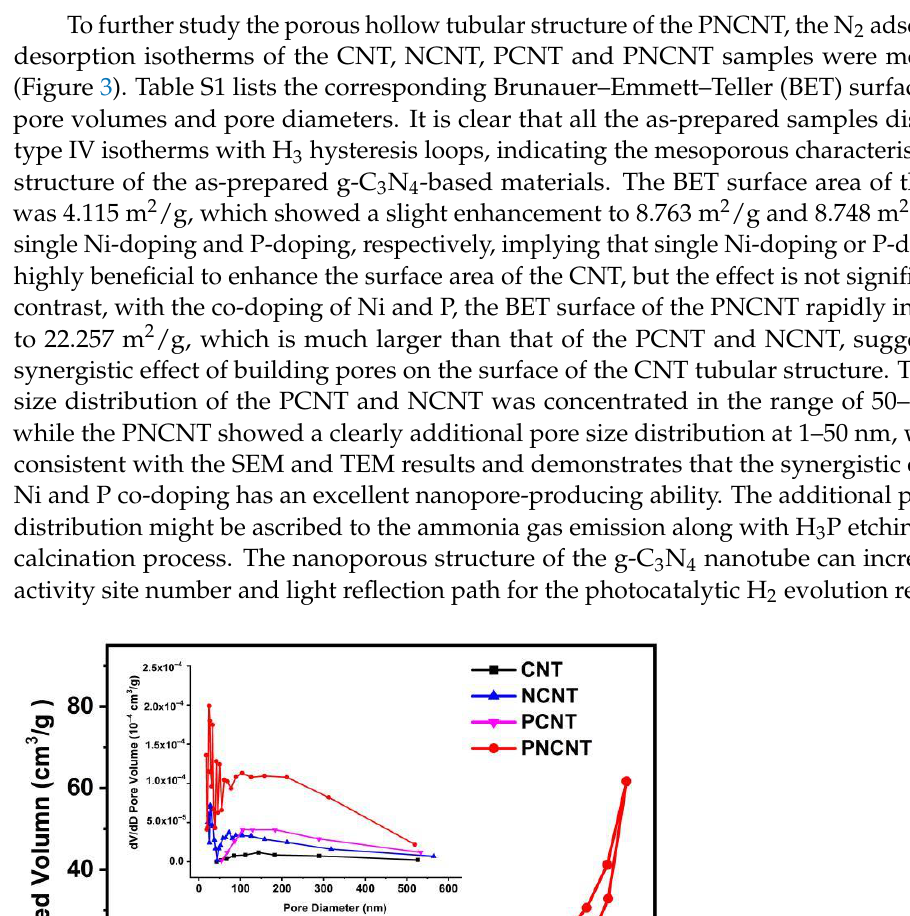
Figure 2. TEM images of hollow tubular morphology ( a ) and surface porous state ( b ) of PNCNT samples.